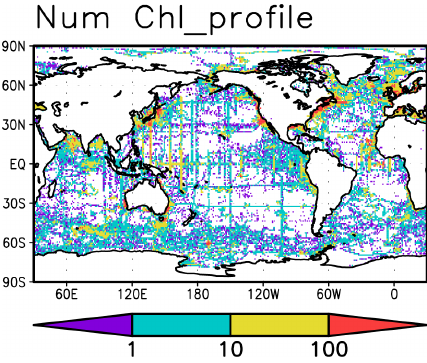
Figure 1. Number of Chl a concentration profiles in different areas.